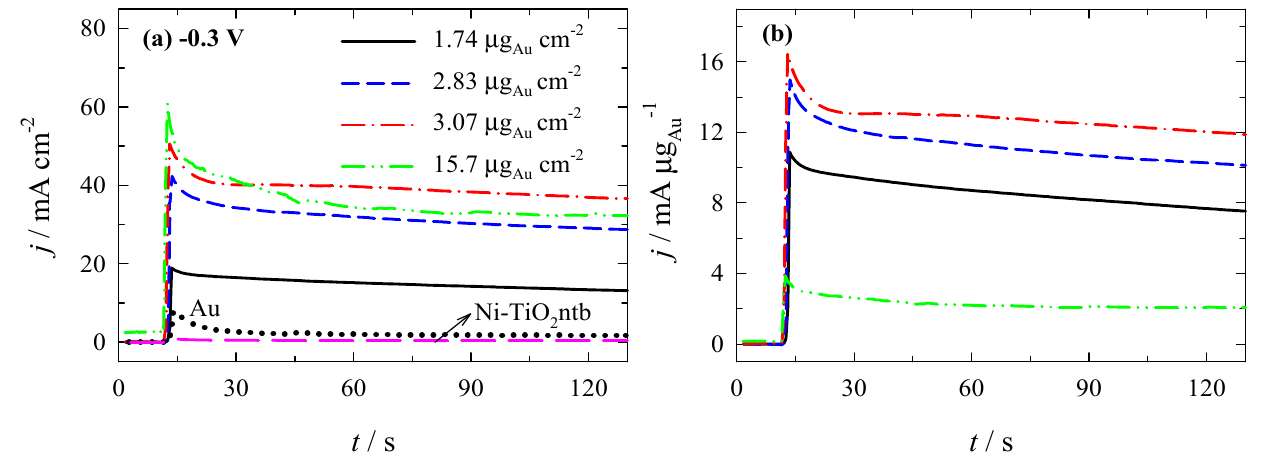
Figure 11. ( a ) Chronoamperometry curves of the AuNi-TiO 2 ntb catalysts in a 0.05 M NaBH 4 + 1 M NaOH solution at 25 °C. AuNi-TiO 2 ntbs were prepared by the dipping of TiO 2 ntb in the Ni plating solution operated at 85 °C for 60 s, followed by their dipping in the Au plating solution for time (s): 10 (solid line), 20 (dashed line), 60 (dash-dotted line), and 300 (dash − dot-dotted line). The potential was held at E = 0 for 10 s, then set to − 0.3 V for 2 min. ( b ) Chronoamperometry curves were normalized by the Au loadings for each AuNi-TiO 2 ntb catalyst. The electrocatalytic stability of the AuNi-TiO 2 ntb catalyst was examined herein by numerous cycling in a 0.05 M NaBH 4 + 1.0 M NaOH solution between − 1.1 and 0.6 V at 10 mV·s − 1 . Figure 12 shows CVs after long-term potential cycling (after 6 h) for the AuNi- TiO 2 ntb catalyst that has the Au loading of 15.7 μ g А u ·cm − 2 . After the six-hour continuous cycling, the value of anodic peak A related to BH 4 − ion oxidation was slightly lowered and slightly shifted toward positive values. Thus, long cycling results in the disappearance of the first anodic peak A0. Hence, it may be suggested that the fabricated electrode is electrocatalytically active and stable after long-term cycling.